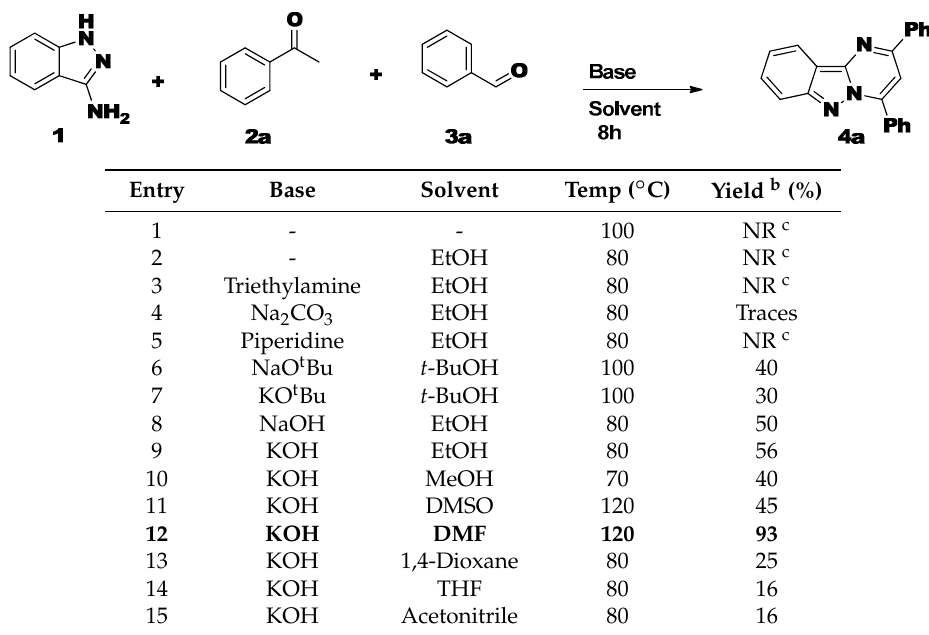
Table 2. Optimization of cascade reaction to synthesis compound 2,4-diphenylpyrimido[1,2- b ]indazole ( 4a ) via metal free conditions a .